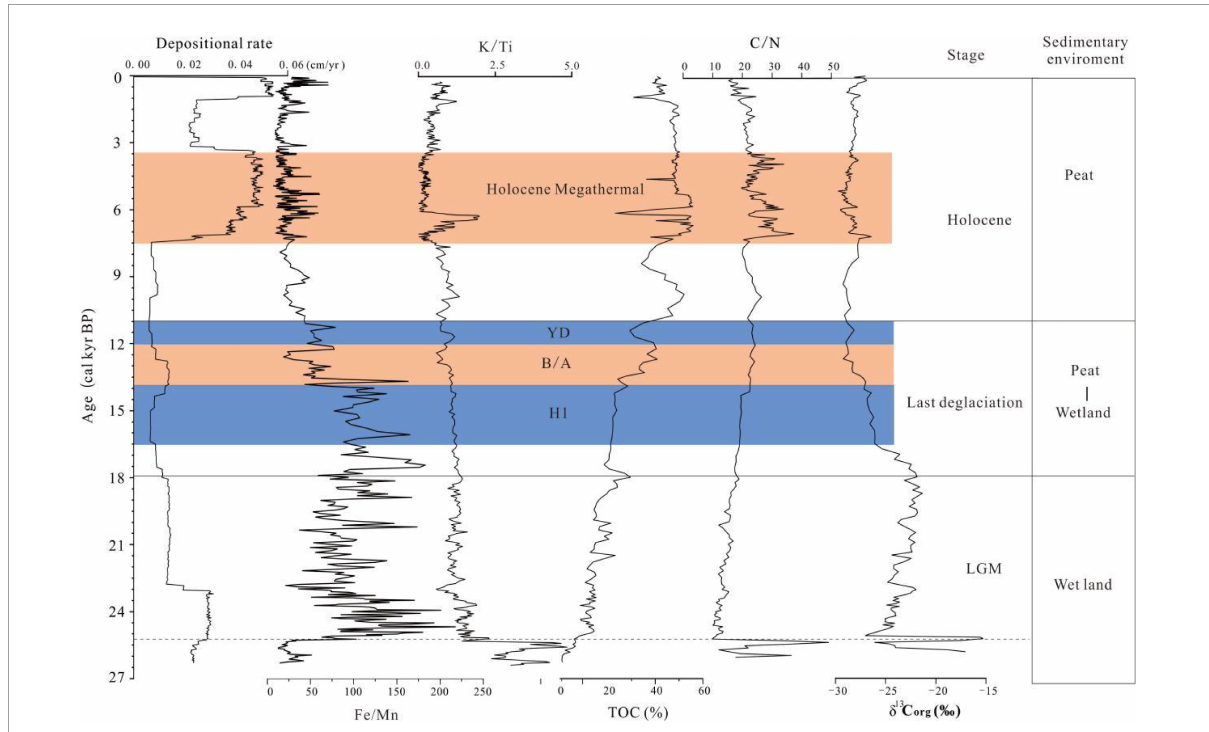
FIGURE6 Comparison of paleoenvironmental indicators since the LGM in the GC core.